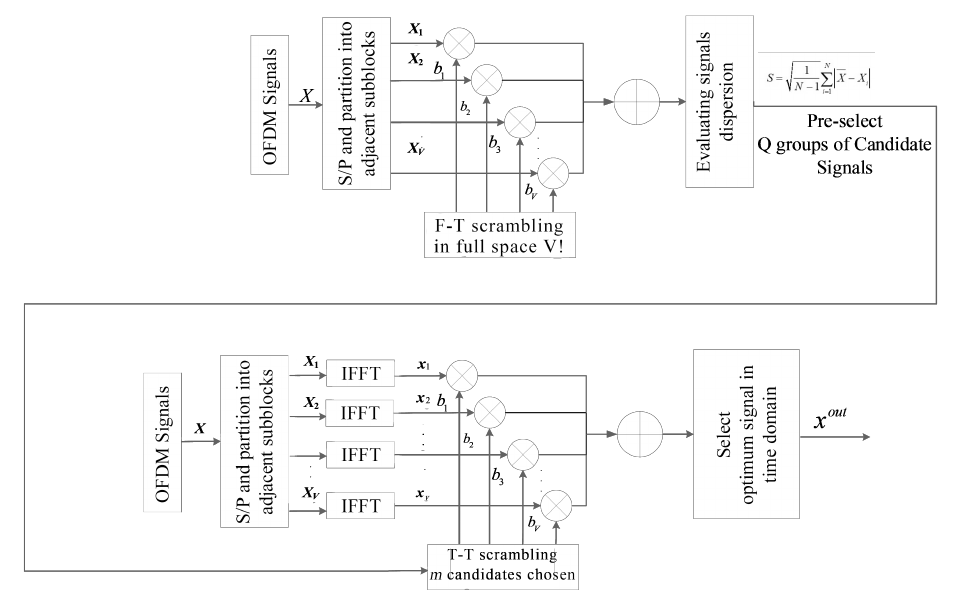
Figure 6. Structure of the FTD-PTS